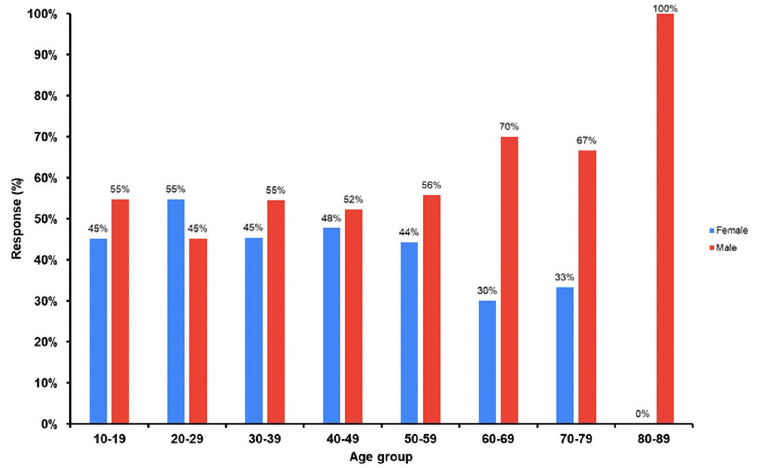
Fig 1. Age groups and gender proportion for recovered COVID-19